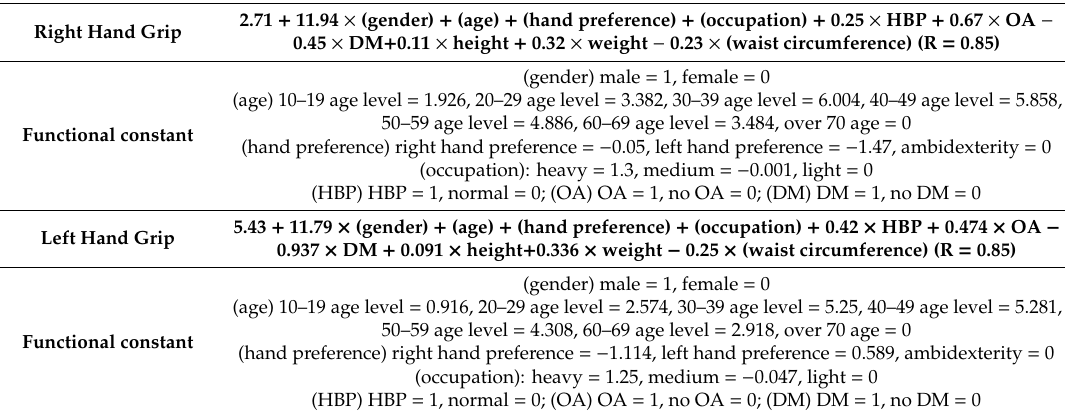
Table 5. The Suggested Formula for Estimating Grip